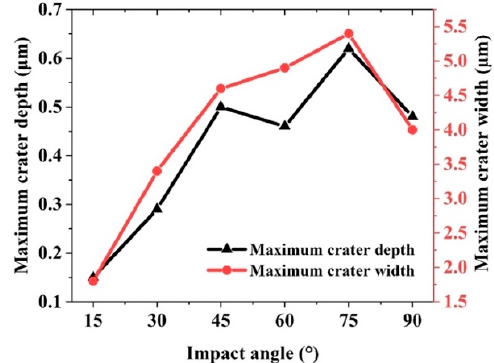
Figure 10. Maximum depth and width of craters under different impact angles.